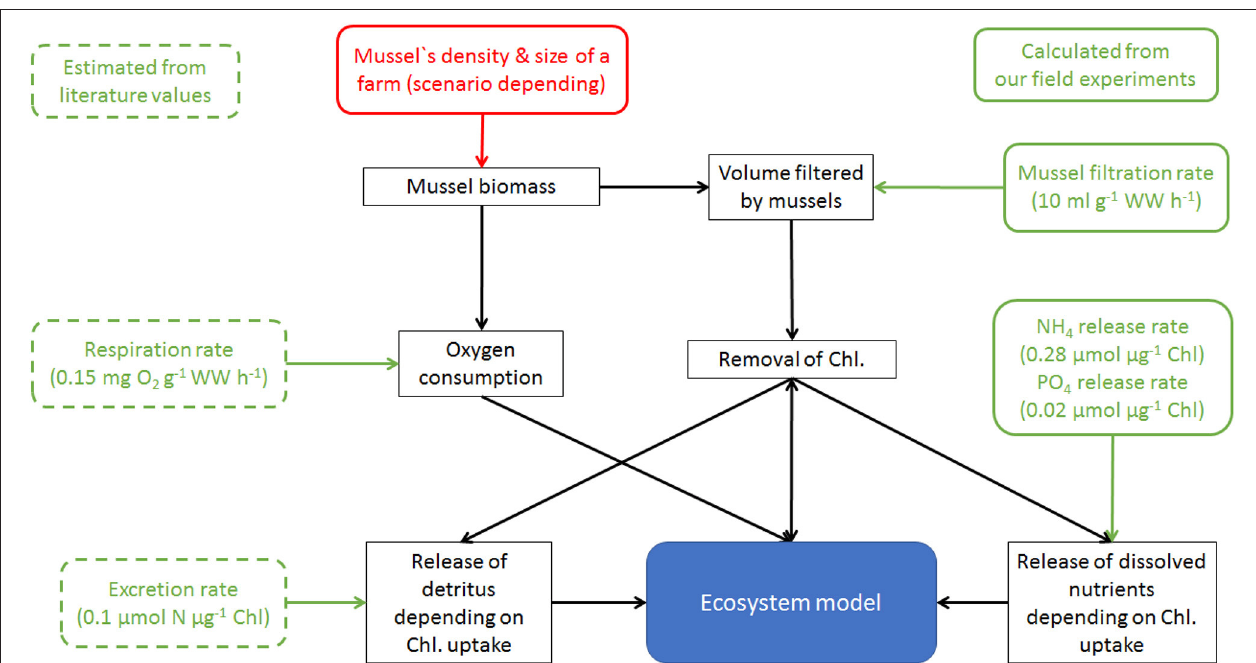
FIGURE 1 | Simplified sketch of the mussel farm module (black rectangles) and its integration into the model system by calculating changes of Chlorophyll, detritus, PO 3 − 4 , NH + 4 and Oxygen. Green are incorporated parameters, taken either from own field experiments (solid lines) or literature